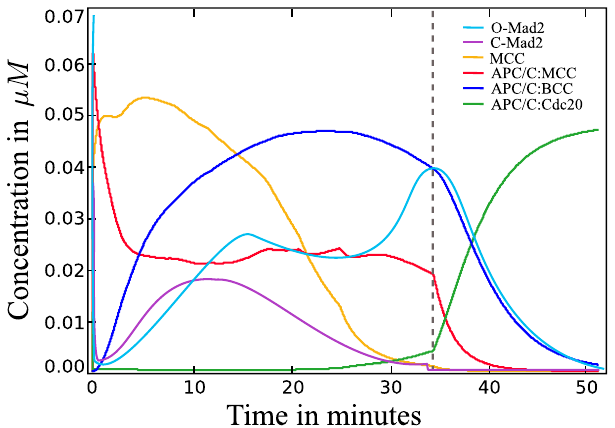
Figure 3. Wild-type concentration over time for the labeled species. The dashed line indicates attachment of the last kinetochore. The MCC is produced quickly and decays continuously. APC/C:MCC rapidly captures and disables APC/C molecules. Apc/C:MCC and APC:Cdc20:MCC yield the less stable APC/C:BCC. APC/C:Cdc20 is present during the whole process and reaches its full activity in the period of the last